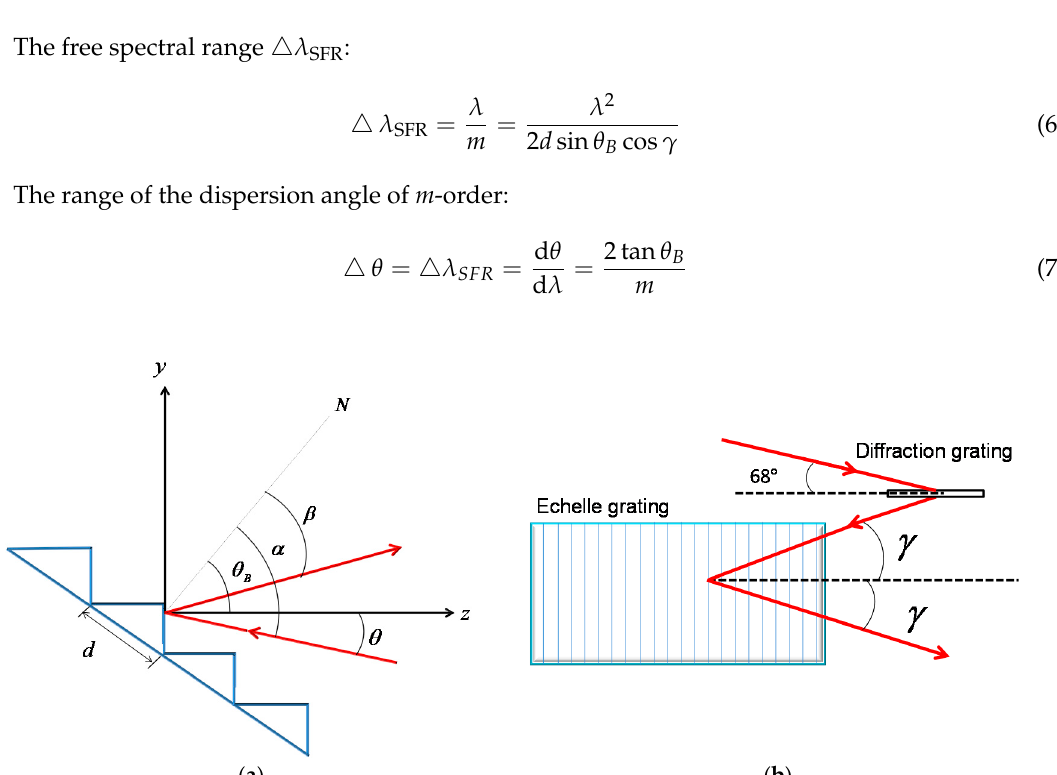
Figure 1. ( a ) Echelle grating working characteristics, ( b ) off-axis angles γ (the incident angle of diffraction grating is 68°).